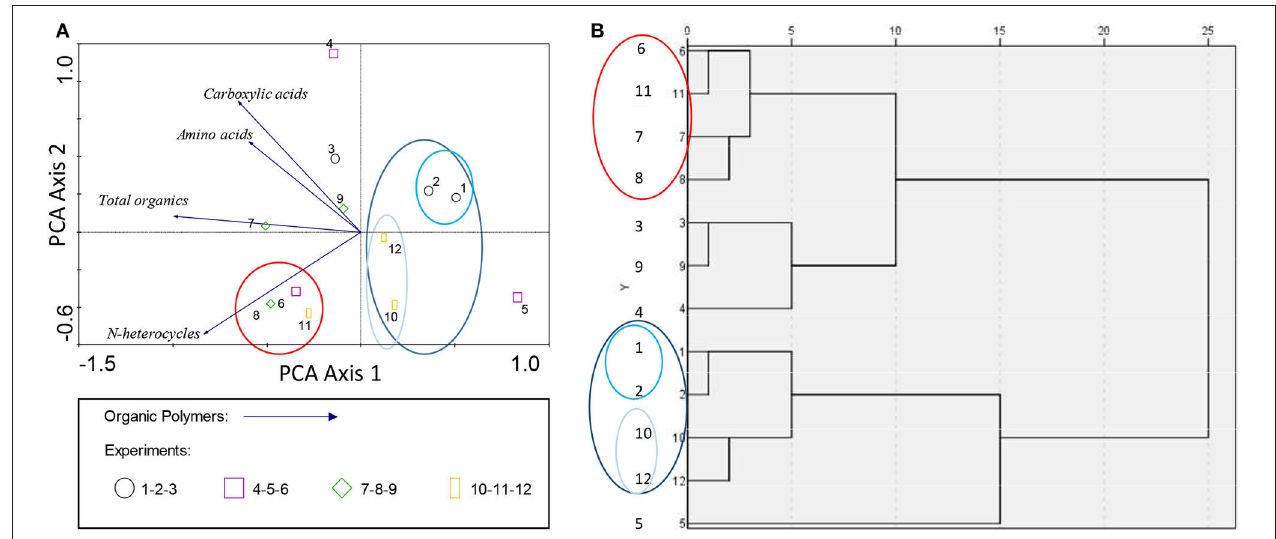
FIGURE 3 | (A) PCA plot based on the relative proportion of amino acids, carboxylic acids, N-heterocycles, and total organics obtained in every experiment for the insoluble polymers. Relative proportions of the different compounds are indicated by arrows. The observed clusters are indicated by circles. (B) Hierarchical dendrograms calculated using PCA components. Experiments are represented by their numbers. The obtained clusters are designated by circles.